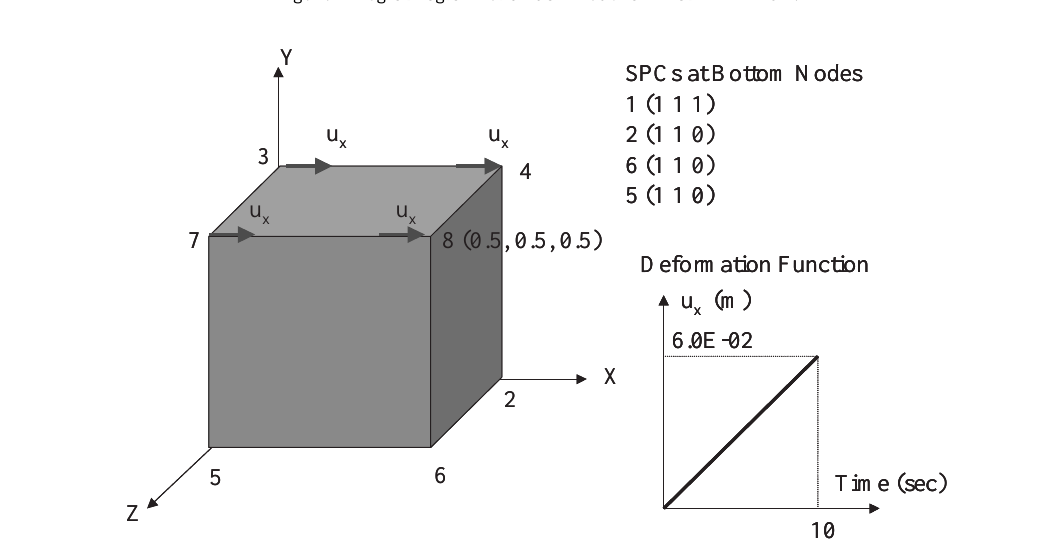
Fig. 2. A Logic Diagram for umat41 Routine in LSDYNA-MCT.